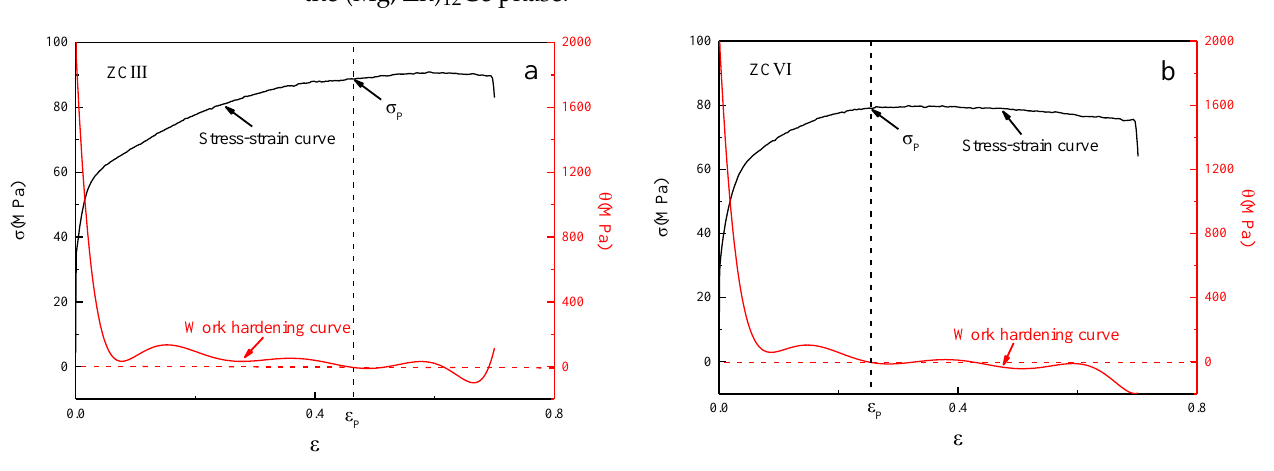
Figure 16. Typical stress–strain and θ − ε curves. ( a ) ZCIII alloy, ( b ) ZCVI alloy. Figure 17 shows the relationship between the peak stress and the number of (Mg, Zn) 12 Ce phases in the experimental alloy. With the increase of compound content in alloys with different Zn content, the peak stress increases, and the changing trend is consistent. However, it can be seen that the peak stress is obviously lower in 6 wt.% Zn alloy with a higher number of compounds, which is attributed to the role of the (Mg, Zn) 12 Ce phase in the process of thermal deformation. The increase in the number of (Mg, Zn) 12 Ce phases reduces the critical conditions for dynamic recrystallization and greatly advances the dynamic softening effect in the alloy. In the corresponding stress–strain curves, ZCIV, ZCV, and ZCVI alloys show peak stress at small strain. In addition, the increase in the number of (Mg, Zn) 12 Ce phases also strengthens the PSN mechanism, provides conditions for the nucleation of recrystallized particles, and inhibits their growth, which corresponds to the stress reduction stage in the stress–strain curve. The above analysis results show that controlling the amount of the (Mg, Zn) 12 Ce phase can not only predict the properties of the alloy during the current deformation process but also adjust the trend of the stress–strain curve to obtain ideal mechanical properties.